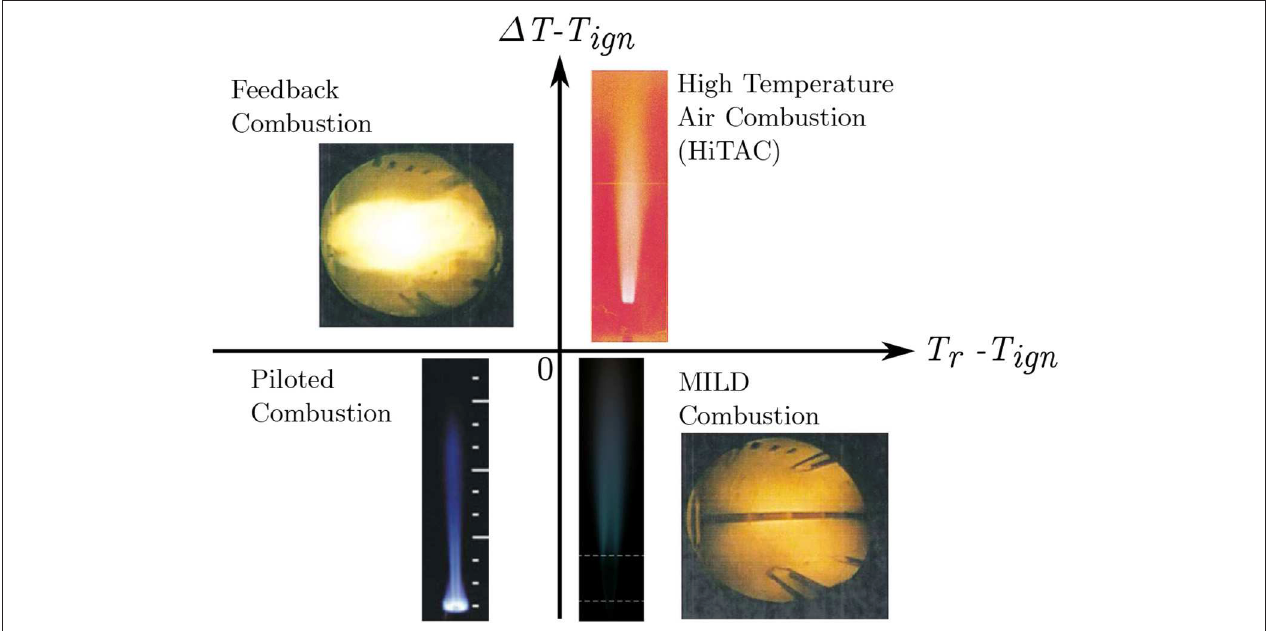
FIGURE 2 | A diagram showing various combustion types: HiTAC (Fujimori et al., 1998), feedback or conventional (de Joannon et al., 2000), piloted (Dunn et al., 2010 ), and MILD (de Joannon et al., 2000; Medwell et al., 2007) combustion. This diagram is adapted from Doan (2018) under a Creative Commons